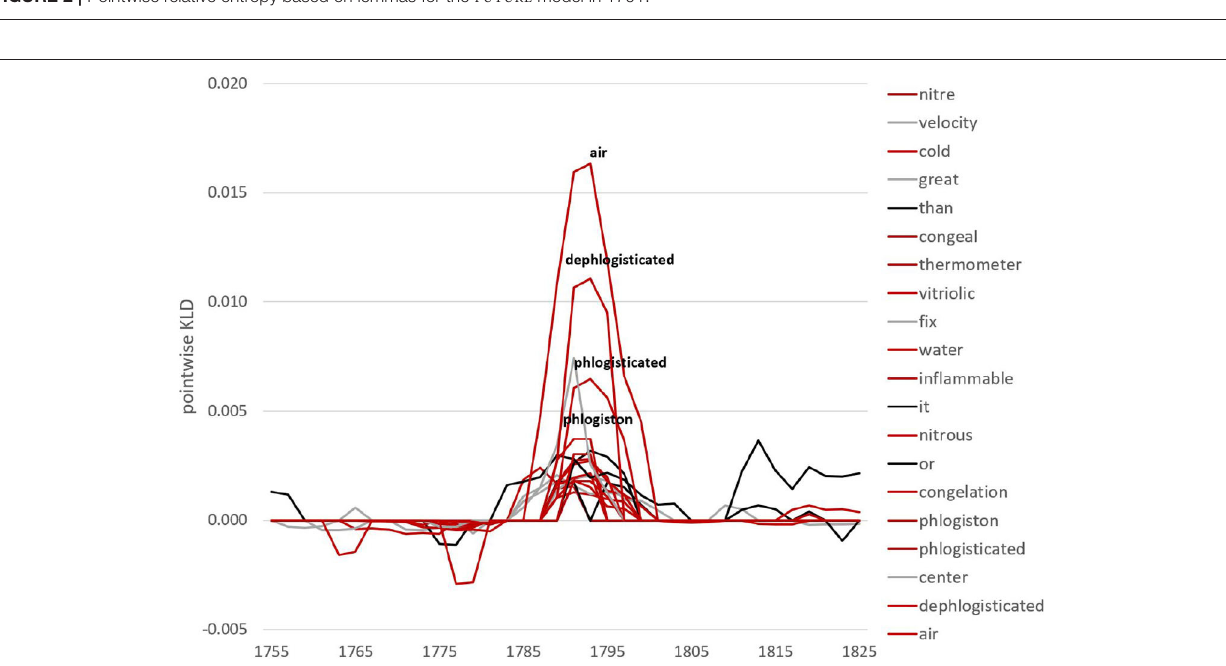
FIGURE 3 | Pointwise relative entropy based on lemmas for the PAST model in